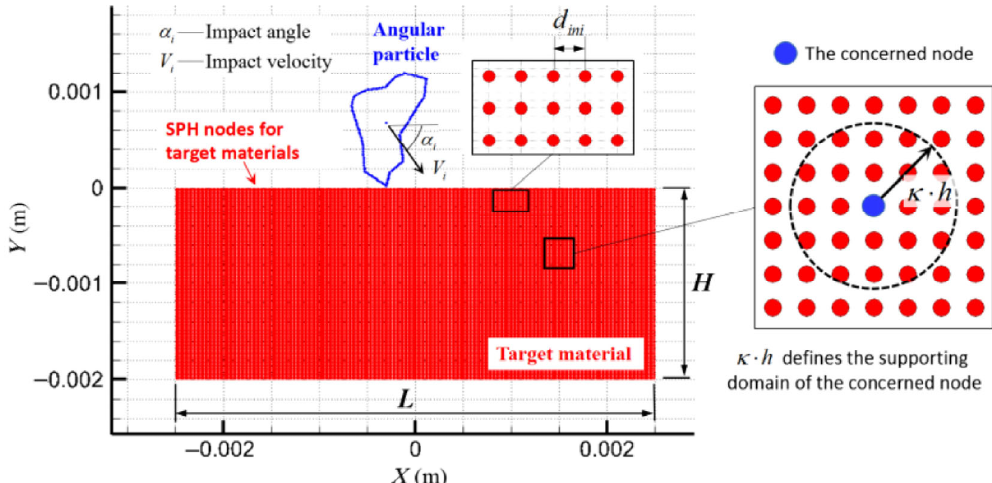
Fig. 30 A schematic discrete erosion model. Reproduced with permission from Ref. [671]. © World Scientific Publishing,